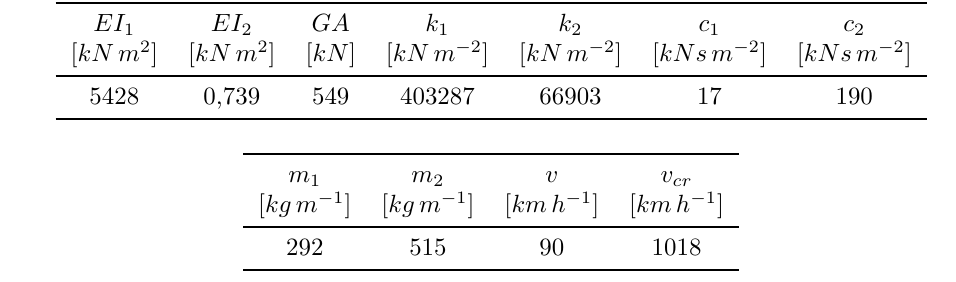
Table 1. Analytical model